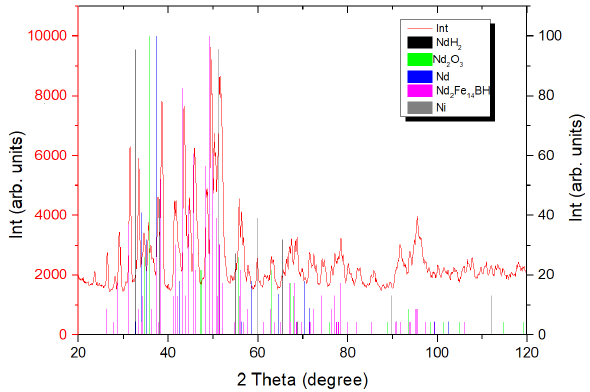
Figure 1. X-ray diffraction pattern of the powder mixture obtained after decrepitation of an N42 Figure 1. X-ray di ff raction pattern of the powder mixture obtained after decrepitation of an N42 magnet magnet and its milling with + 2 wt.% NdH 2 . and its milling with + 2 wt.% NdH 2 The identified phases are typical of powder mixtures obtained after hydrogen decrepitation.